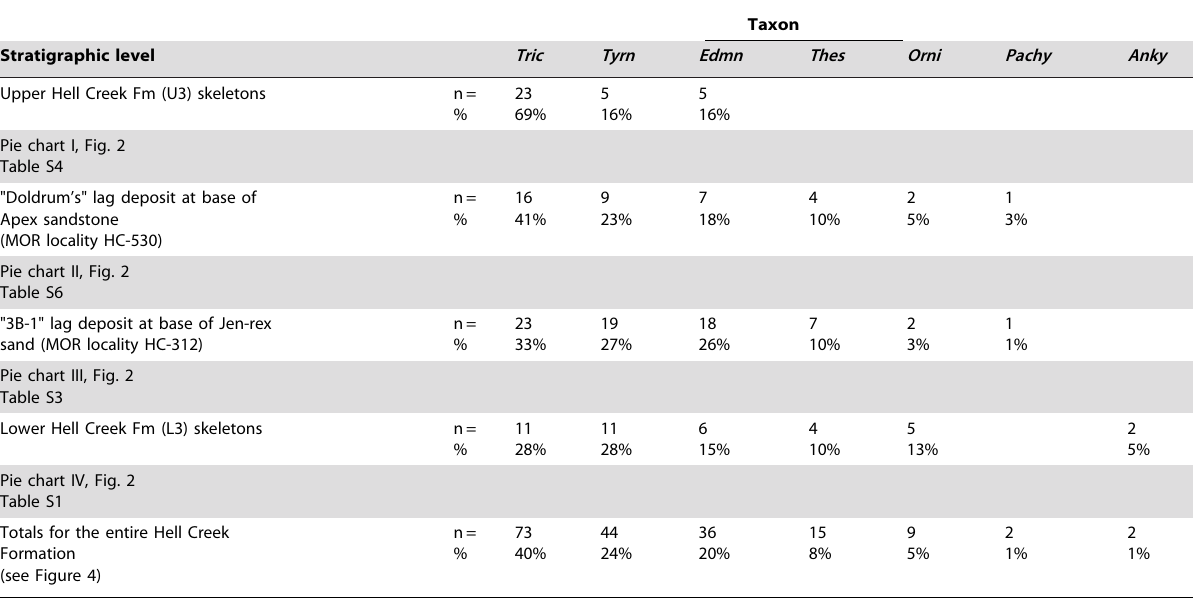
Table 1. Hell Creek Formation dinosaur census.